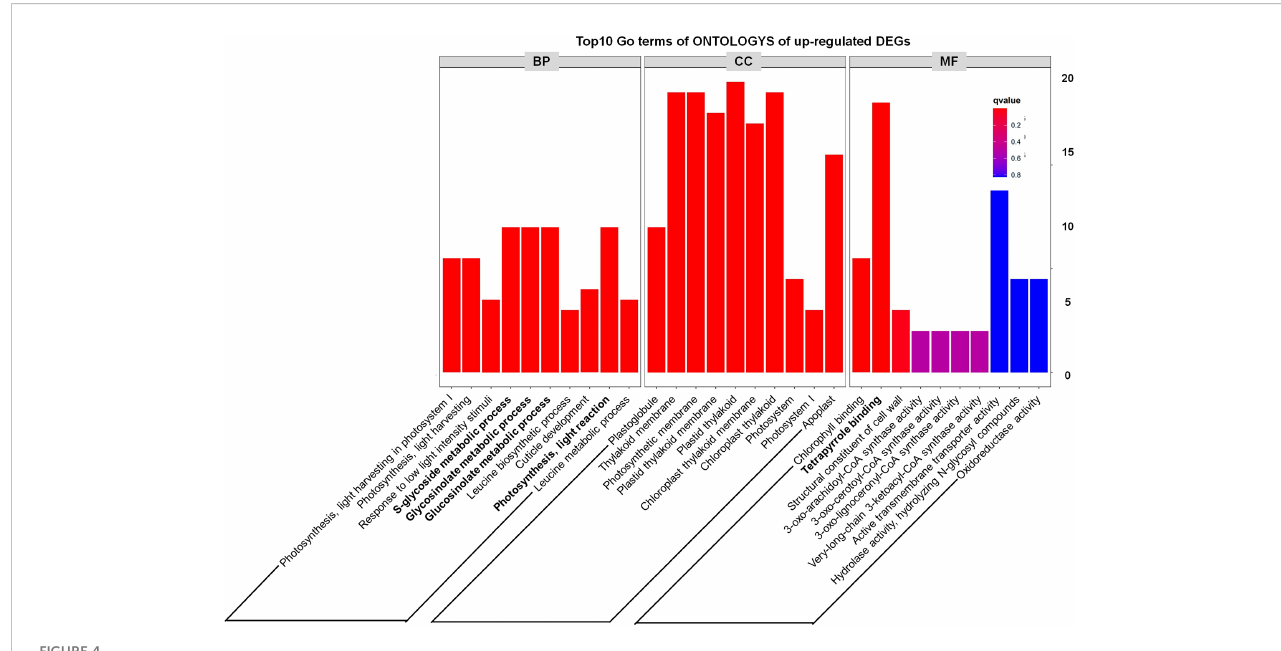
FIGURE 4 GO classi fi cation results of up-regulated